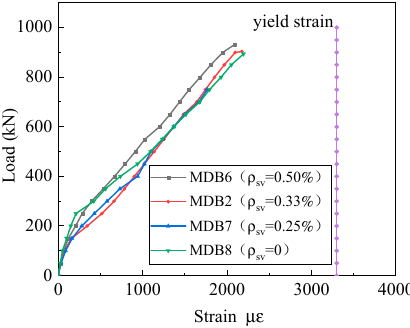
Figure 19. Relation curve between ρ sv and longitudinal reinforcement strain.